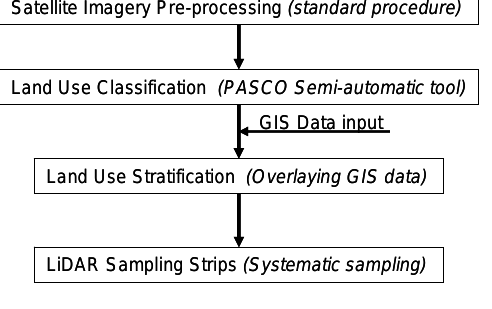
Figure 2. General Workflow